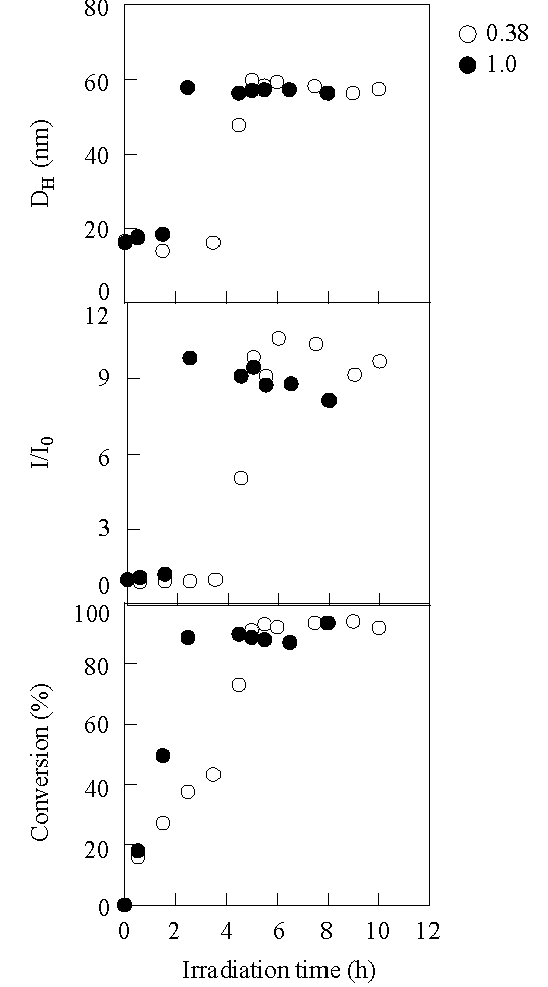
Figure 7. The variation in the hydrodynamic diameter, scattering intensity, and conversion during irradiation at 0.38 (  ) and 1.00 (  ) of DPI/BSt. [copolymer] Mn(PBSt- b -PSt) = 15,000- b